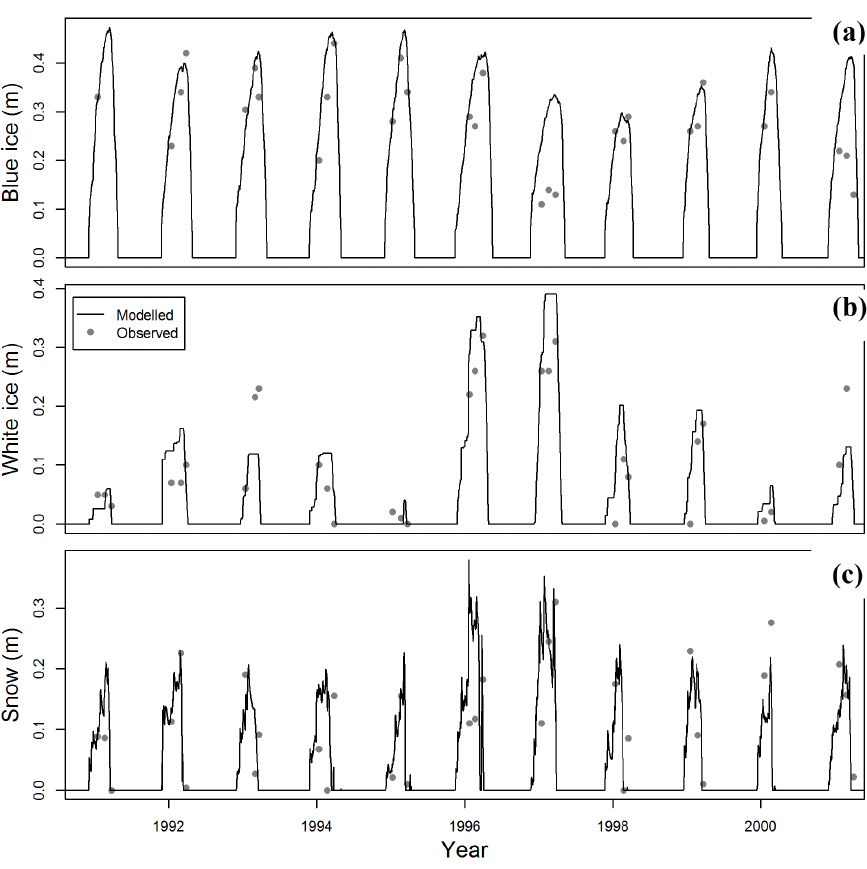
Figure 7. Example of modelled and observed thickness of (a) blue ice, (cid:49)z blue , (b) white ice, (cid:49)z white , and (c) snow, (cid:49)z snow , for Sparkling Lake, Wisconsin. Points are the average observed